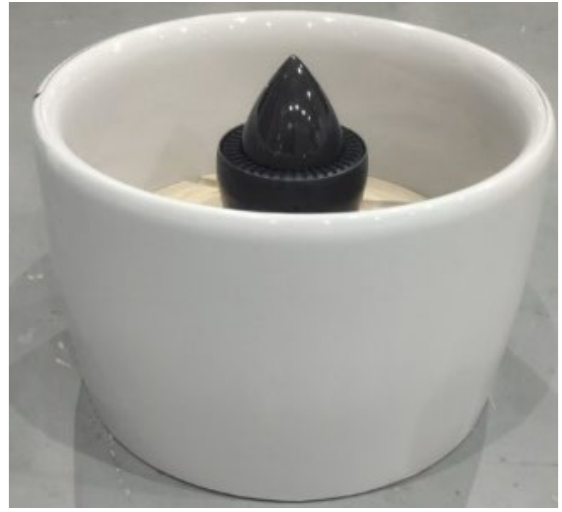
Figure 13. A full-scale prototype of the optimized ducted fan.